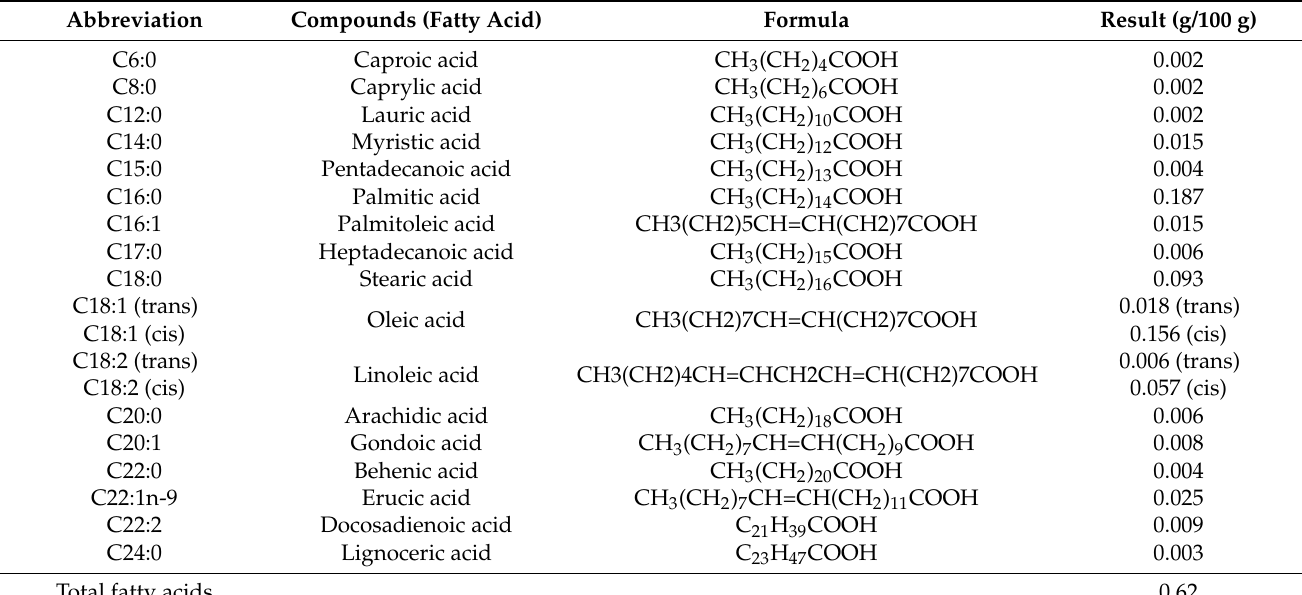
Table 1. Composition of fatty acids and total fatty acids in C. pustulata (CP) (g/100